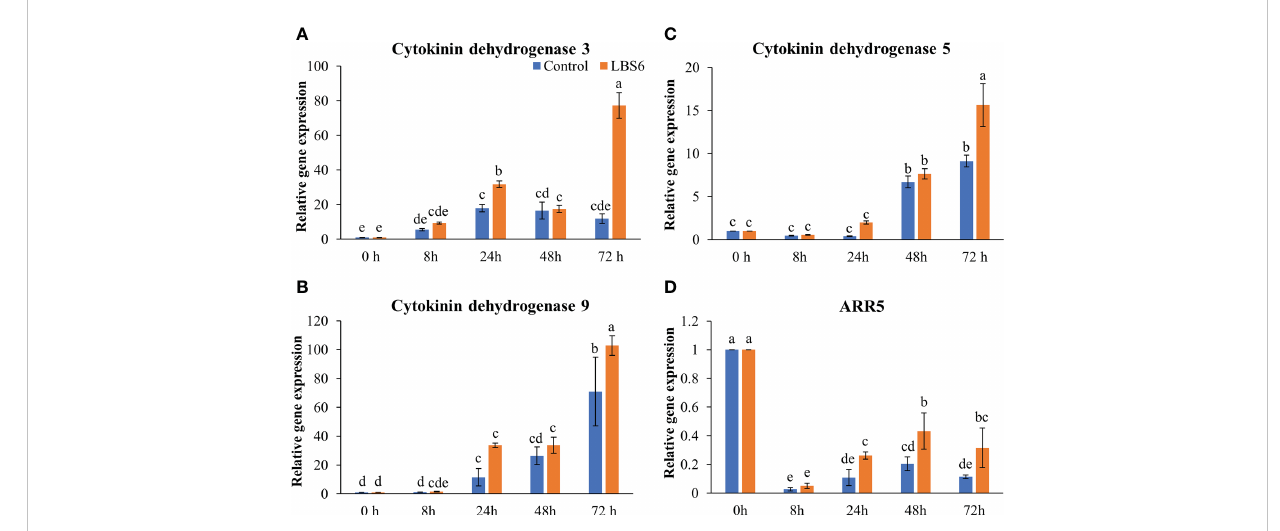
FIGURE 8 LBS6 modulated the expression of (A) Cytokinin dehydrogenase 3 , (B) Cytokinin dehydrogenase 9 , (C) Cytokinin dehydrogenase 5 , and (D) ARR5 involved in cytokinin degradation pathways. The values in the graph represents the relative gene expression. The values were presented as mean ± SE of three independent replicates, and signi fi cantly different mean values were represented by different letters.